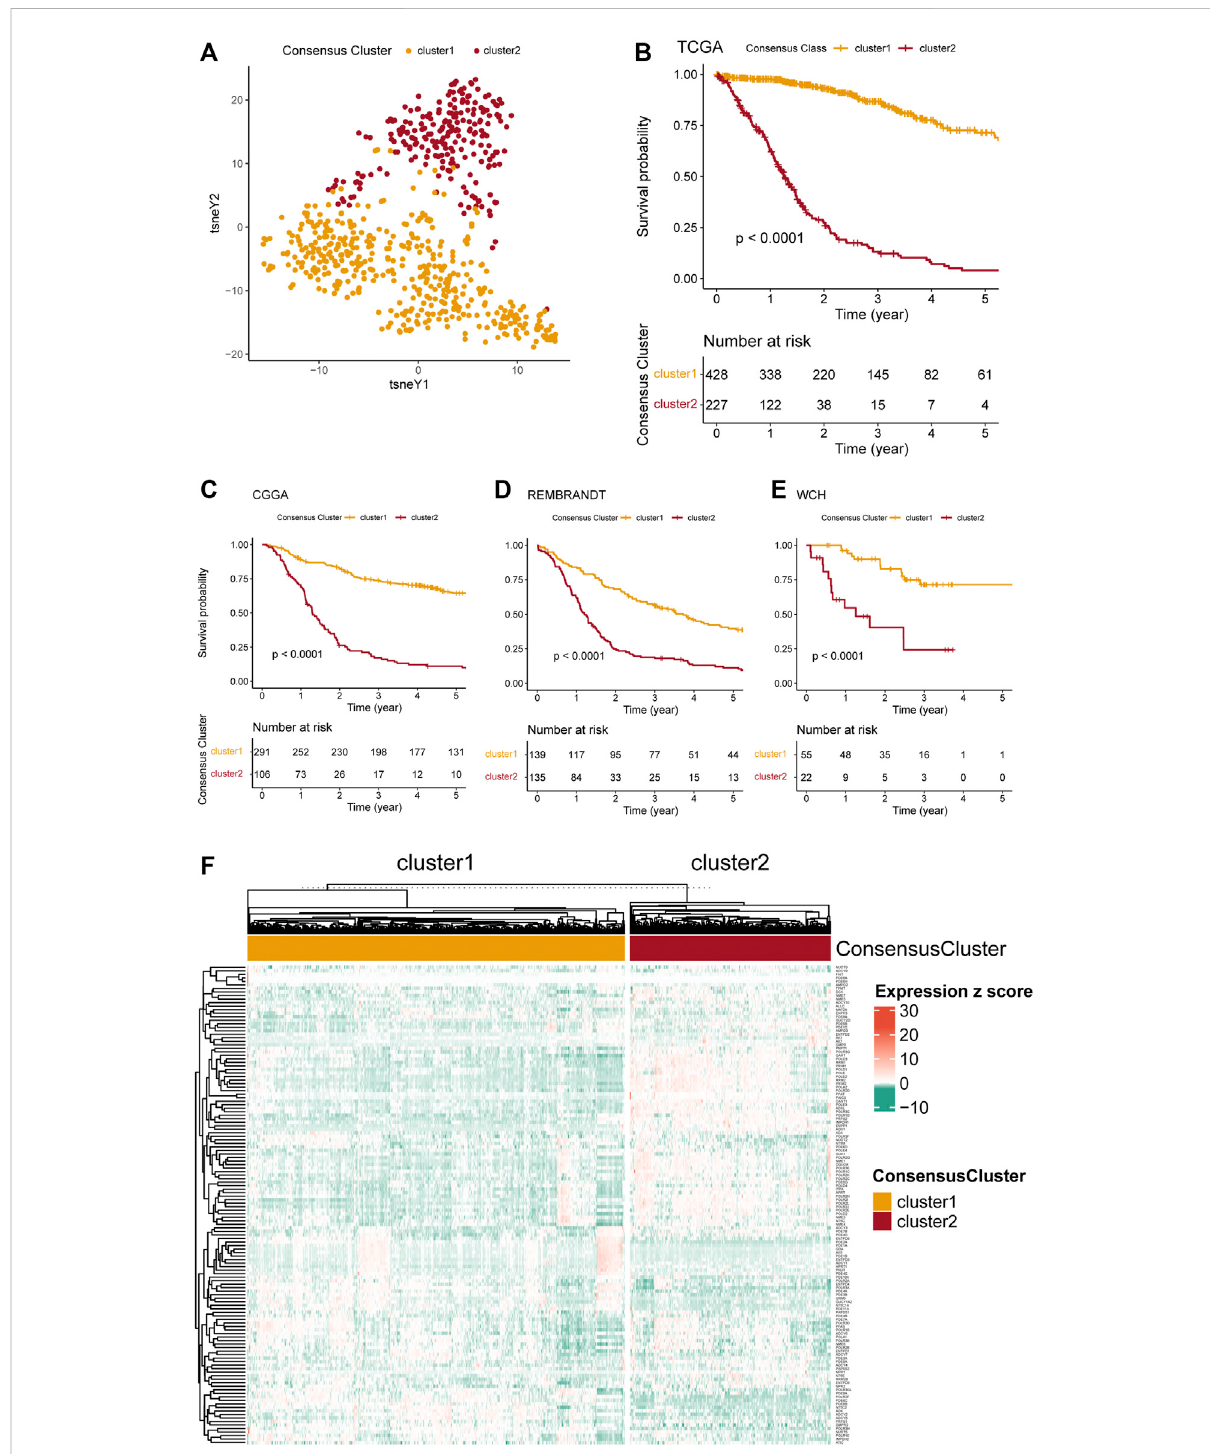
FIGURE 1 Consensus clustering of gliomas based on PuMGs expression. (A) PuMG expression tSNE of the consensus clusters. (B) Kaplan-Meier Curve of the consensus clusters in TCGA cohort ( p < 0.0001). (C – E) K-M Curves of the consensus cluster in CGGA, REMBRANDT, and WCH cohorts ( p < 0.0001). (F) Heatmap for the expression levels of 136 PuMGs between the two consensus